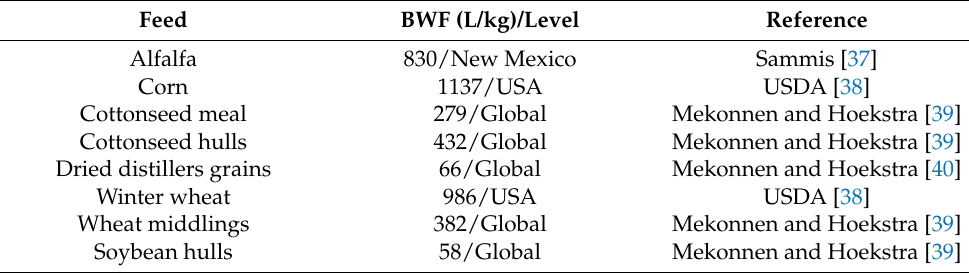
Table 2. Blue water footprint (L/kg) of selected feed components used in this study along with the source of